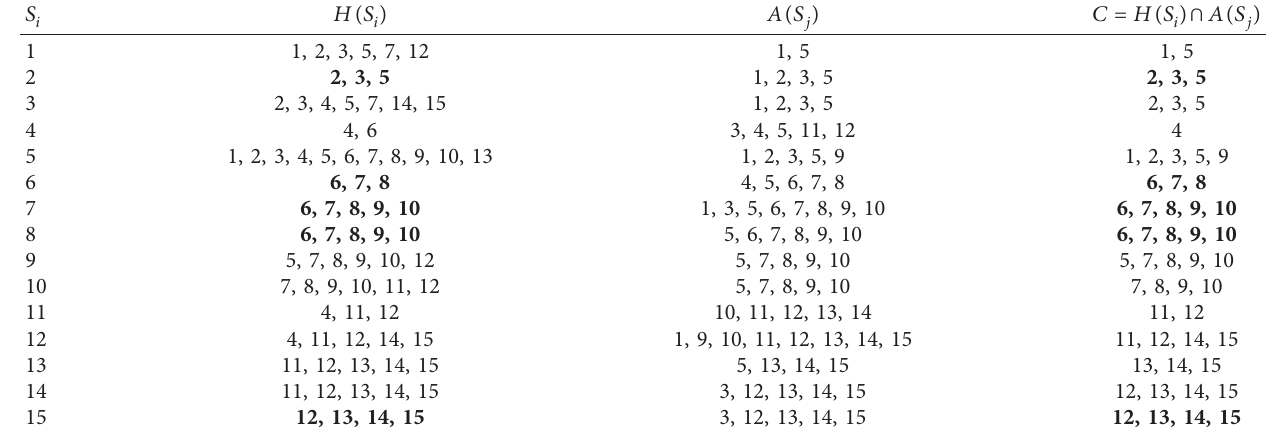
Table 2: First reachable set and antecedent set in reachable matrix H .